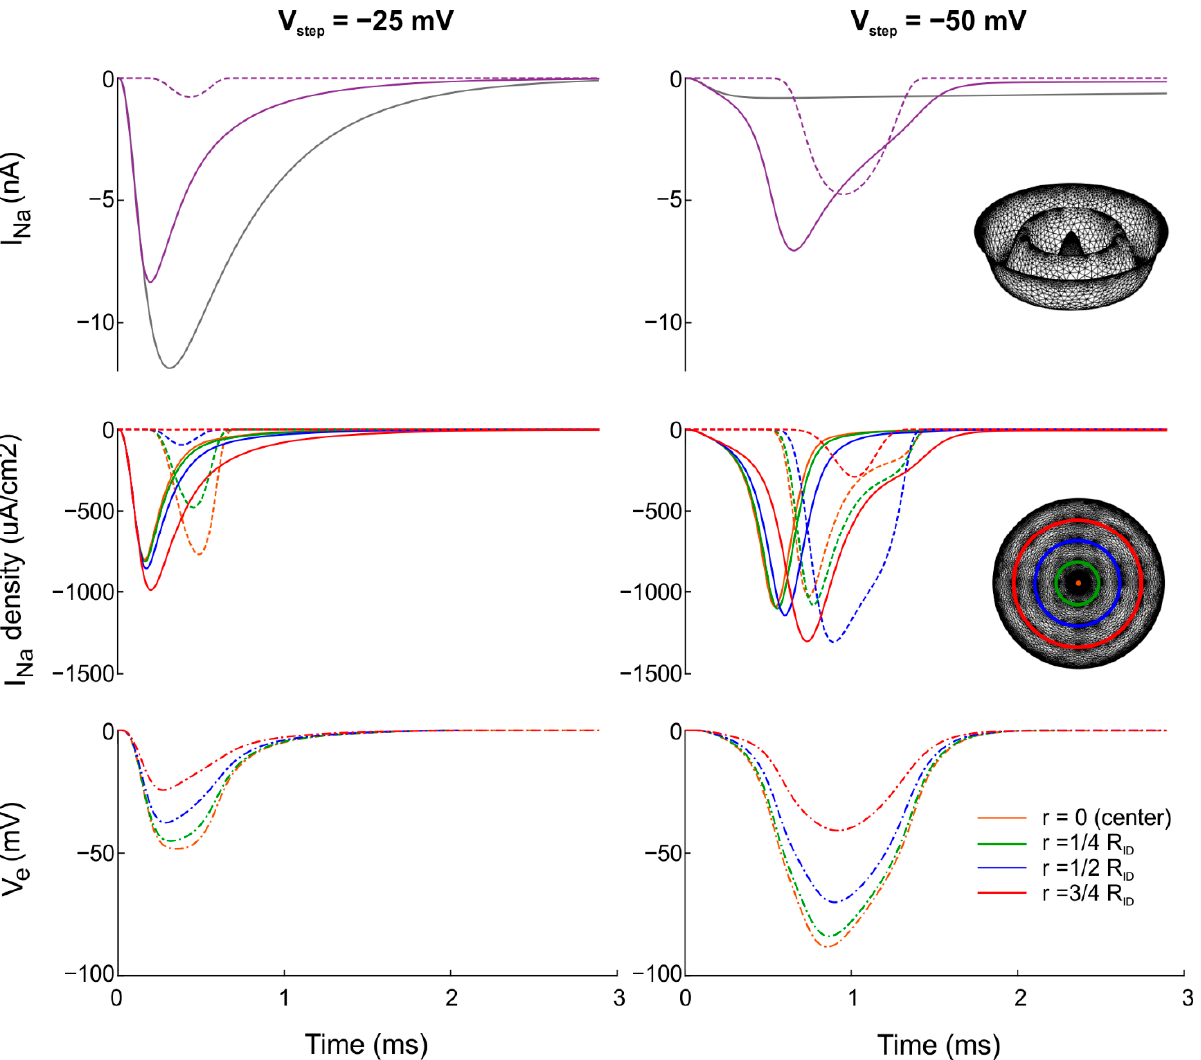
Figure 3. Time course of total I Na with I Na density and V e at different positions in the intercalated disc for a uniform distribution of g Na . Intercalated disc with concentric folds (A = 1/4 R ID and N = 4). The cleft width was 30 nm. The intracellular nodes were subjected to a voltage clamp protocol with V step = –25 mV (left) and V step = –50 mV (right). Top: total I Na in the tortuous intercalated disc (purple). For comparison, total I Na in the pre-junctional membrane without any ephaptic coupling (free membrane) is shown in grey. Middle: I Na density at different distances from the center of the intercalated disc (inset). Continuous and dotted curves correspond to total I Na and I Na density in the pre- and post-junctional membranes, respectively. Bottom: V e at the corresponding positions in the intercalated disc.